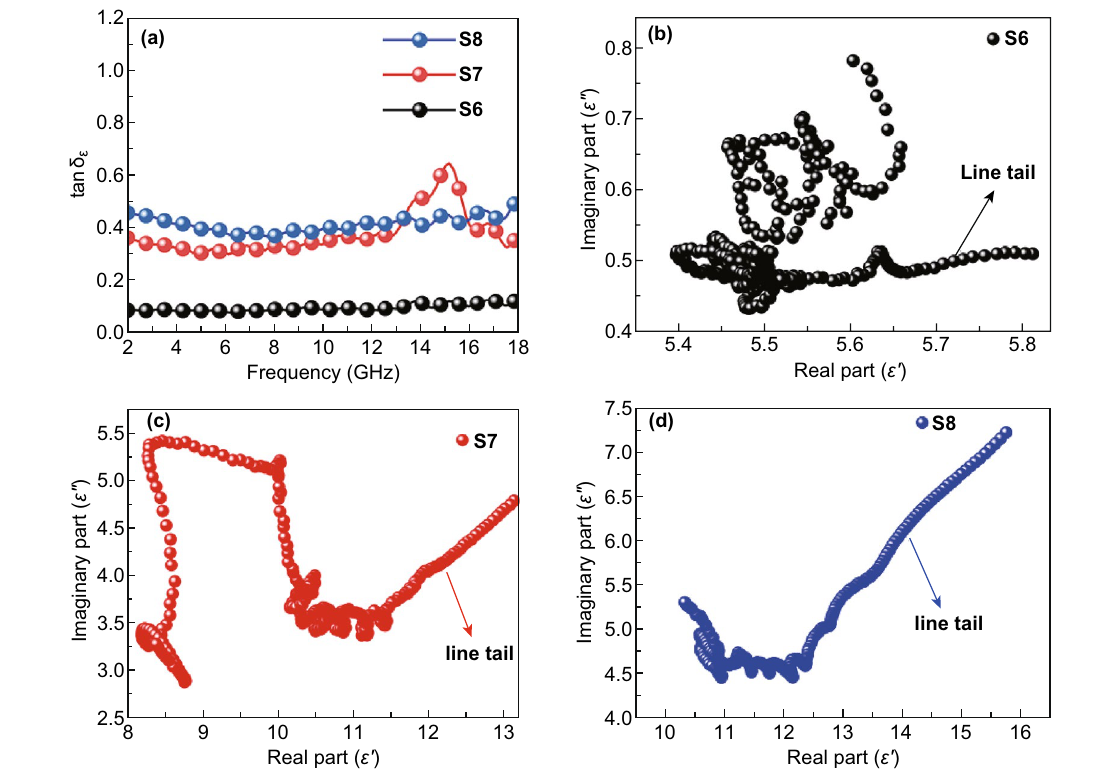
Fig. 5 a Dielectric loss tangent of S6, S7, and S8 from 2 to 18 GHz. Plots of ε ′ versus ε ″ for b S6, c S7, and d